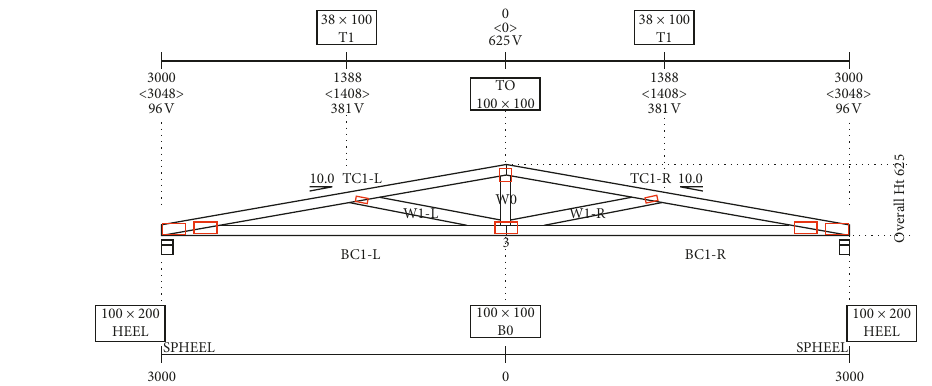
Figure 4: Truss design in Cornerstone software.